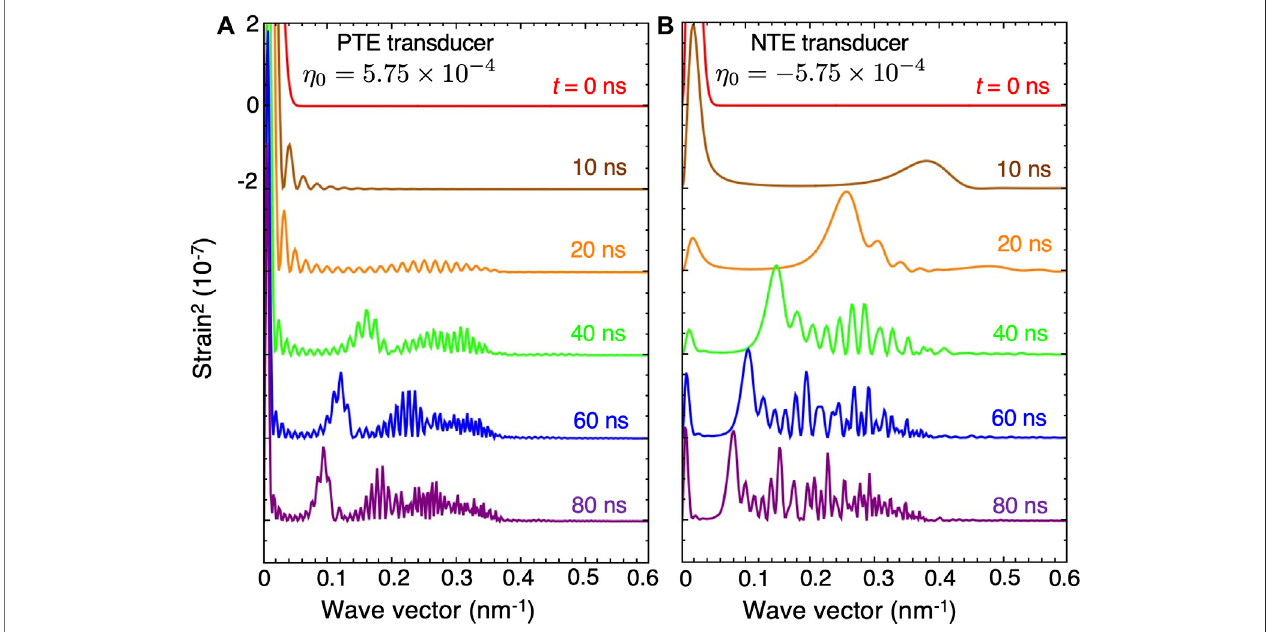
FIGURE 5 | Fourier transform of strain pulses generated in materials with (A) positive thermal expansion for initial strain amplitude 5.75 × 10 – 4 and (B) negative thermal expansion for initial strain amplitude -5.75 × 10 – 4 .